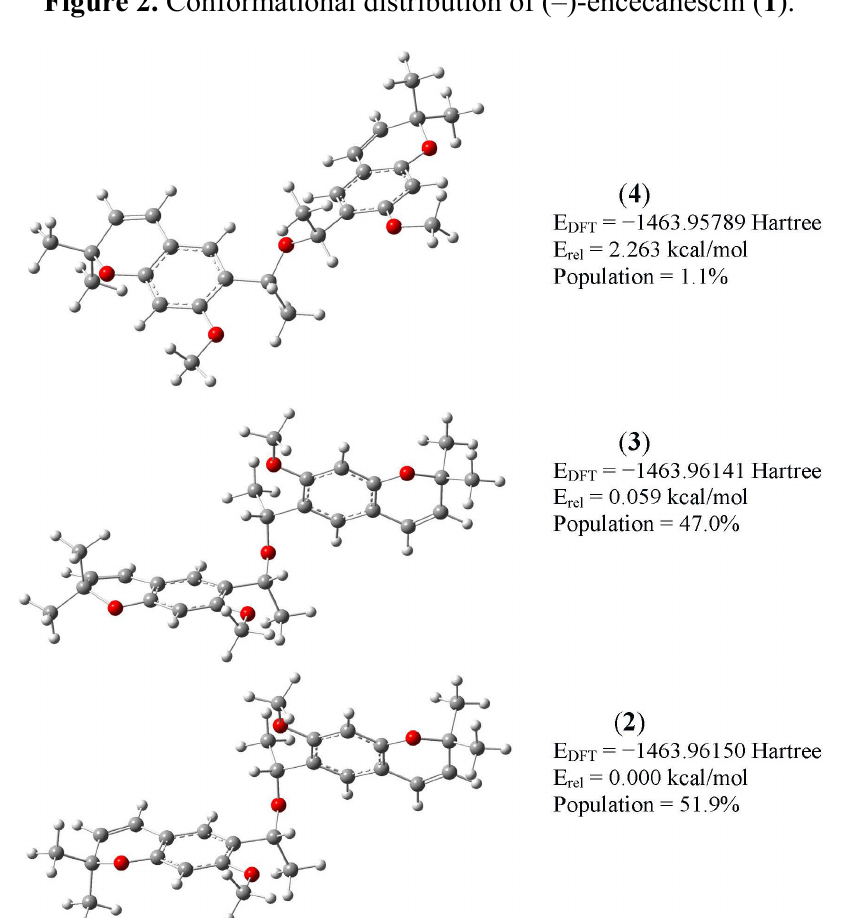
Figure 2. Conformational distribution of ( ‒ )-encecanescin ( 1